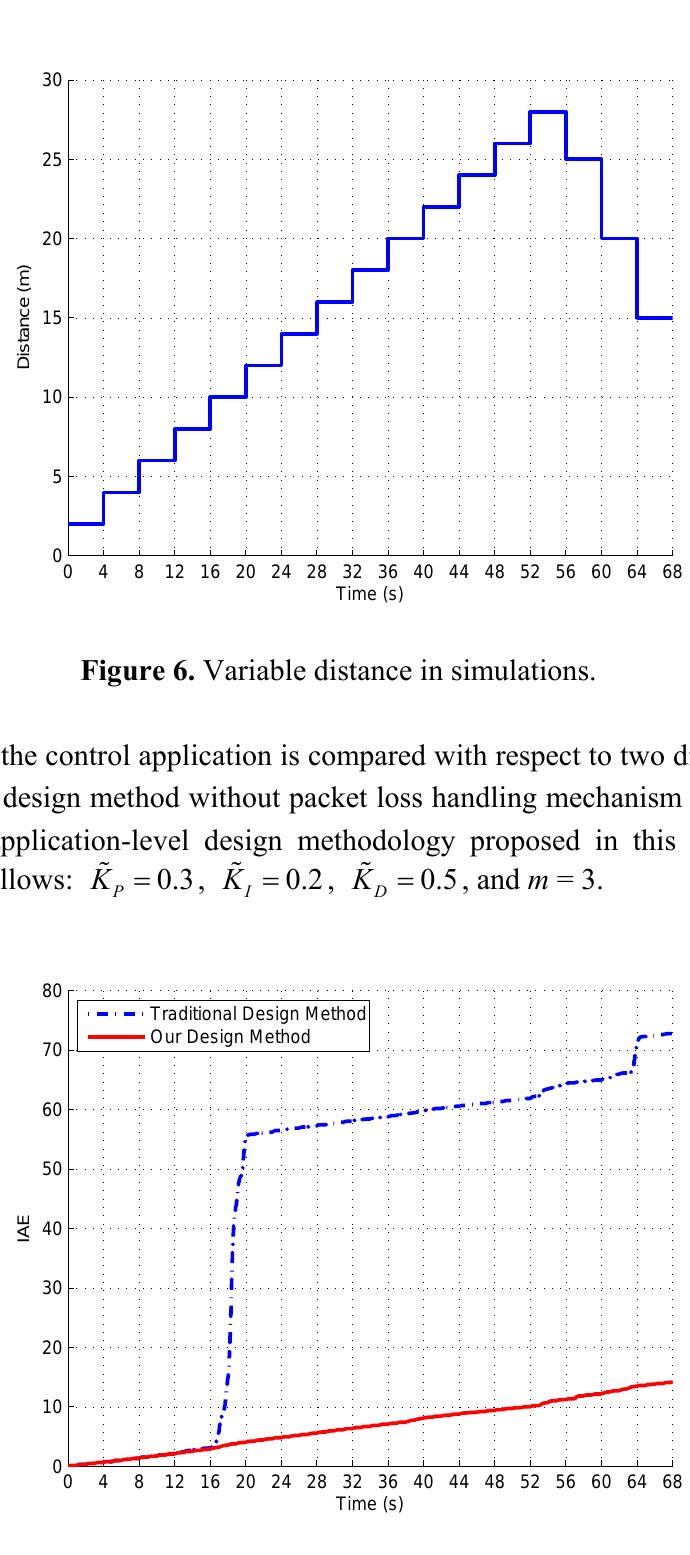
Figure 7. Control performance in terms of